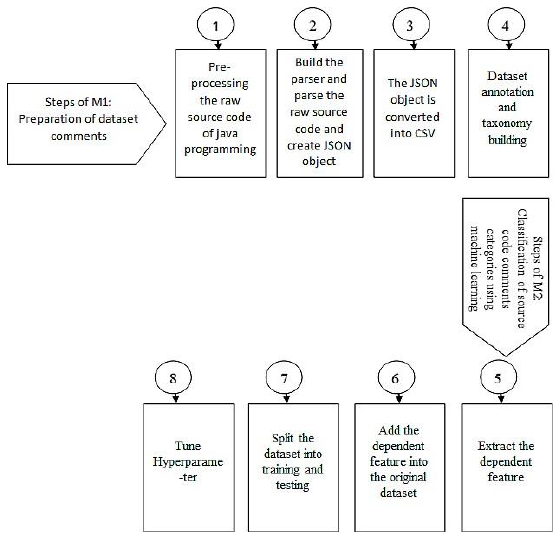
Figure 3. Overall